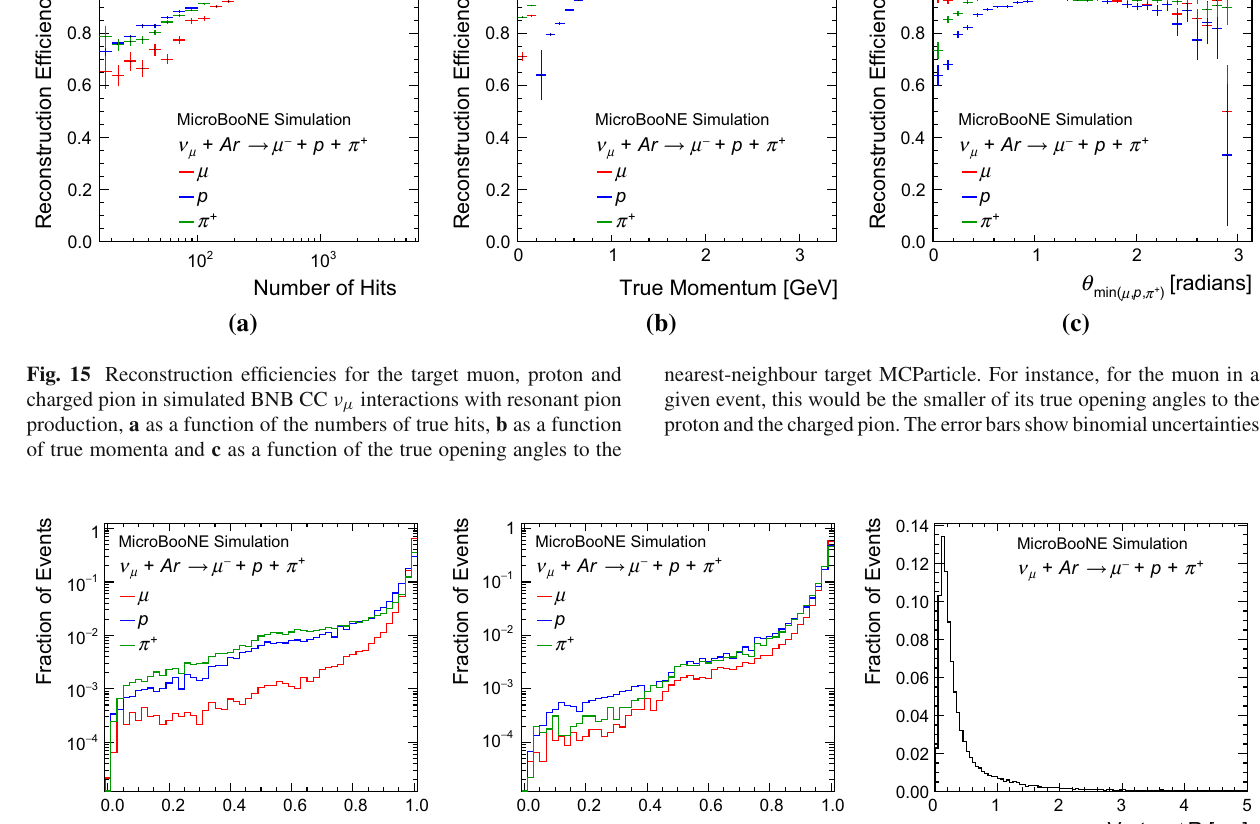
Fig. 16 Completeness ( a ) and purity ( b ) of the reconstructed particles with the strongest matches to the target muon, proton and charged pion in simulated BNB CC ν μ interactions with resonant pion production and c the distance between generated and reconstructed 3D vertex